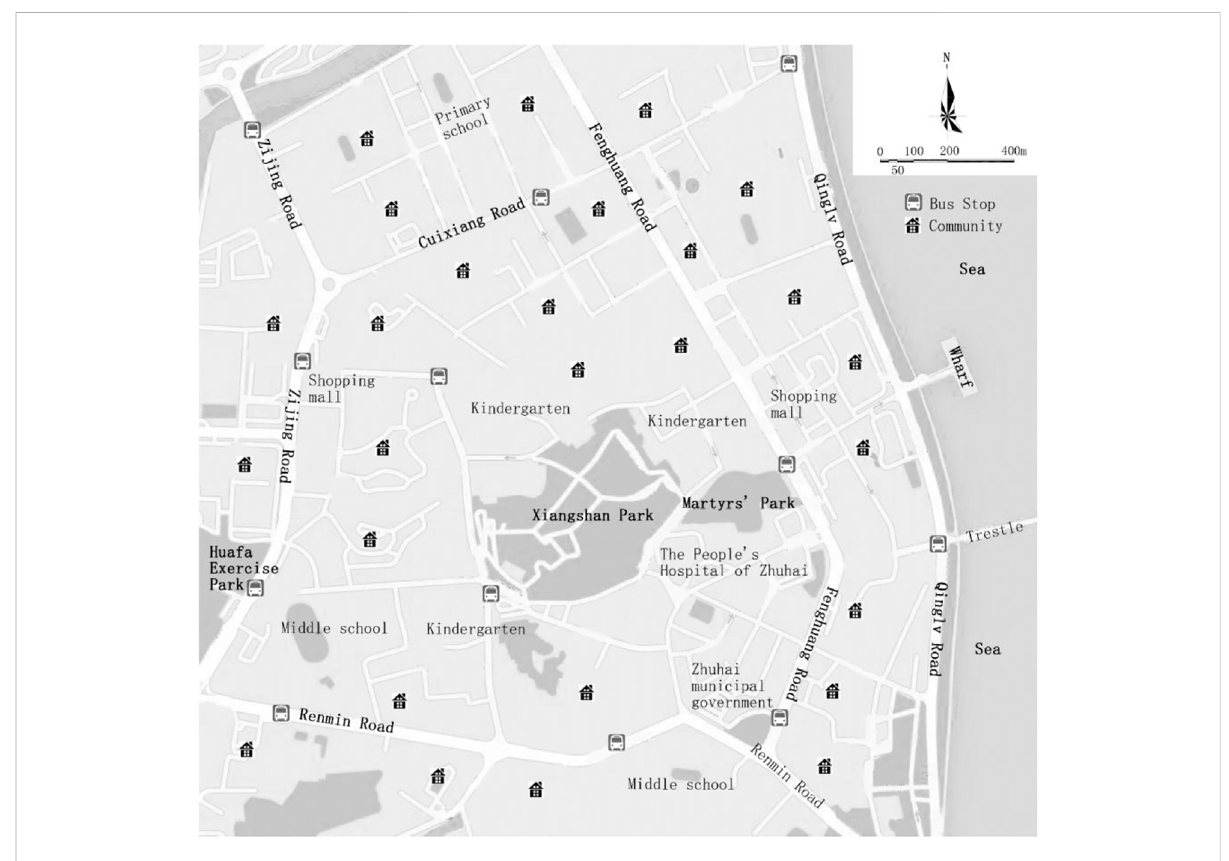
FIGURE 1 ThesiteofXiangshanParkArea,Zhuhaicity,China.Source:CreatedbasedontheplanningmapofGoogleMaps[digitaldata].Basemapavailable at: